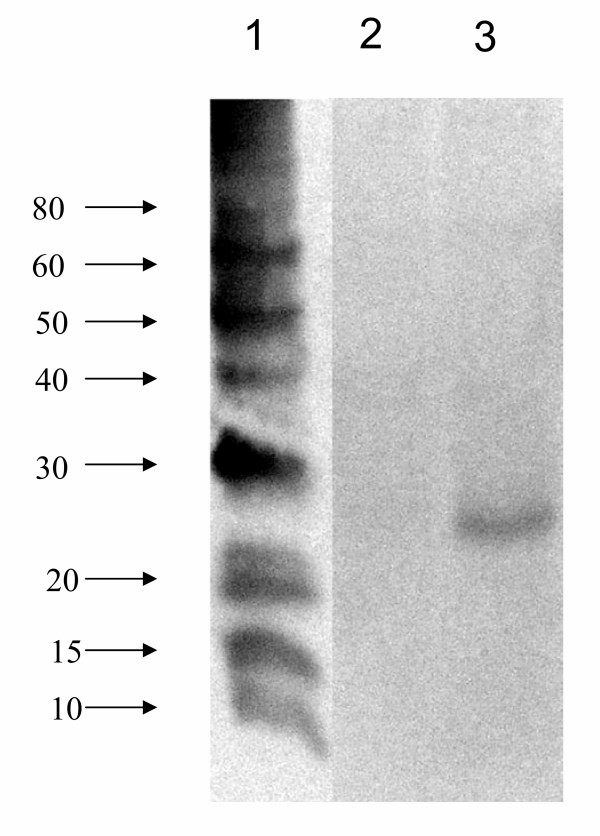
Western blot analysis of hAIDSc expression in yeast. Yeast strain CG379-3-29RL transformed by expression vector pESC-LEU2 or pESC-LEU-hAIDSc were grown to logarithmic phase in a complete minimal medium without leucine. Then cells were washed and transferred into similar medium but containing galactose instead of glucose. Yeast protein extracts were prepared from approximately 200 mg of cells by the glass beads cell disruption method as described in [85]. Proteins were separated using 4–12% gradient PAA NuPage gel (Invitrogen). Transfer to PVDF membrane and reaction with primary antibodies (mouse anti c-myc) and then secondary antibodies (goat antimouse) was accomplished as suggested by the vendor (Western Breeze kit, Invitrogen). Lane 1 – Molecular weight markers (Benchmark, His-Tagged) were detected with antiHisx6 antibodies. Lane 2 – extract of yeast strain containing vector pESC-LEU. Lane 3 – extract of yeast strain containing pESC-LEU-hAIDSc.